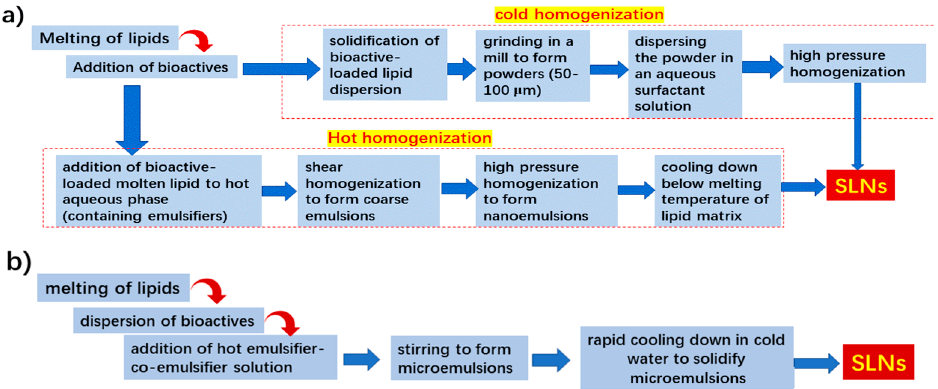
Figure 3. ( a ) The the hot and cold homogenization procedures used to obtain bioactive-loaded solid lipid nanoparticles (SLNs). ( b ) The melt micro-emulsification process used to obtain bioactive-loaded SLNs.